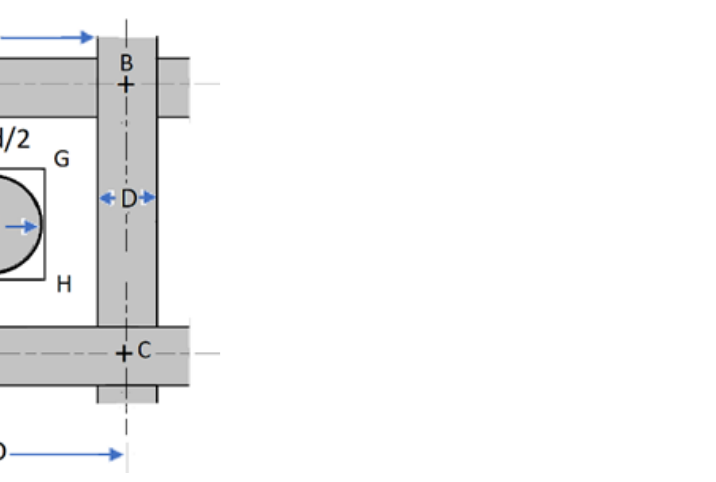
Figure 19. Passage of firebrand with a diameter d through a screen with wire diameter D and aperture a . aperture a